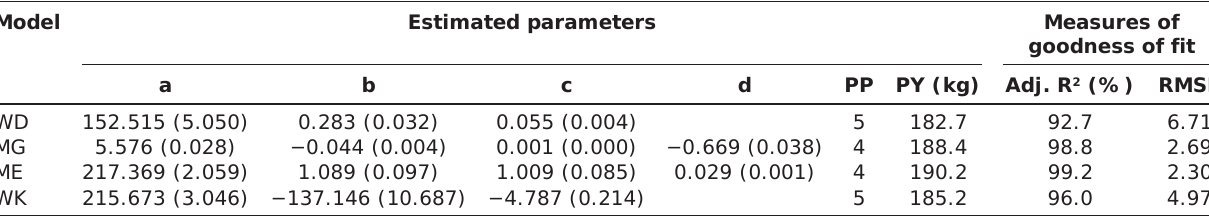
Table-1: Estimated parameters along with their standard error and predicted PP and PY for the different lactation curve models, together with measures of goodness of fit.